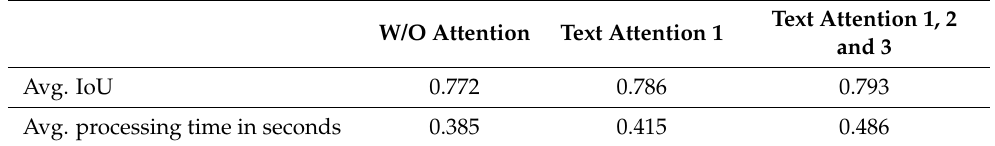
Table 5. Analysis of attention blocks on MSRA-TD500 detections using IoU